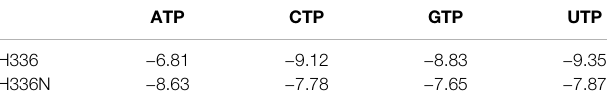
TABLE 2 | Cid1 polymerase substrate binding comparing wild type and H336N mutant.